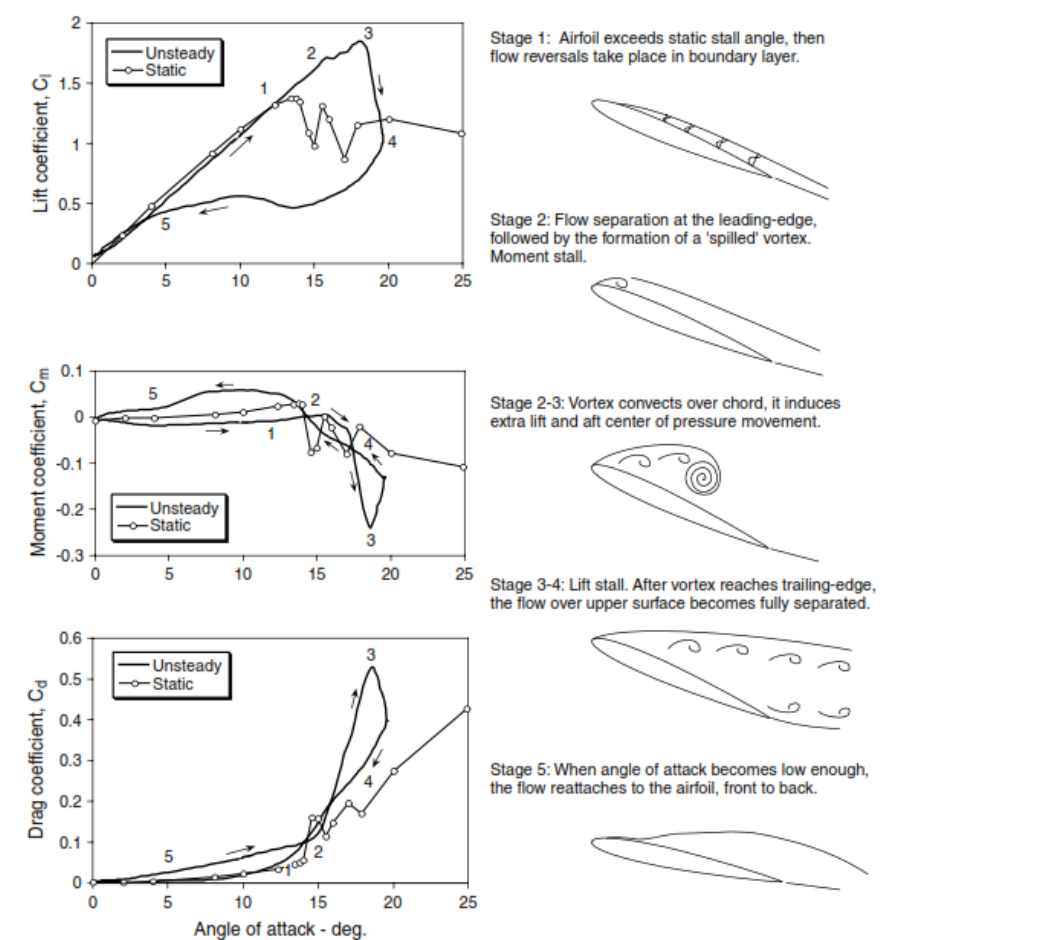
Figure 1. Classical visual representation of dynamic stall (Leishman,